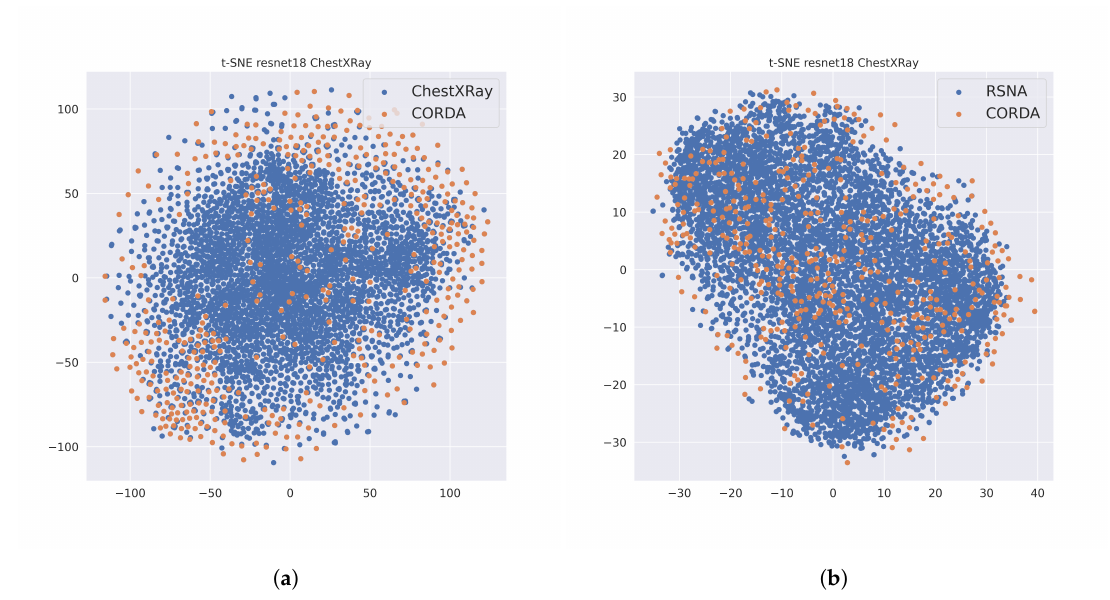
Figure 4. t-SNE on ChestXRay trained encoder. ( a ) shows ChestXRay data vs. CORDA data, ( b ) instead shows RSNA vs.